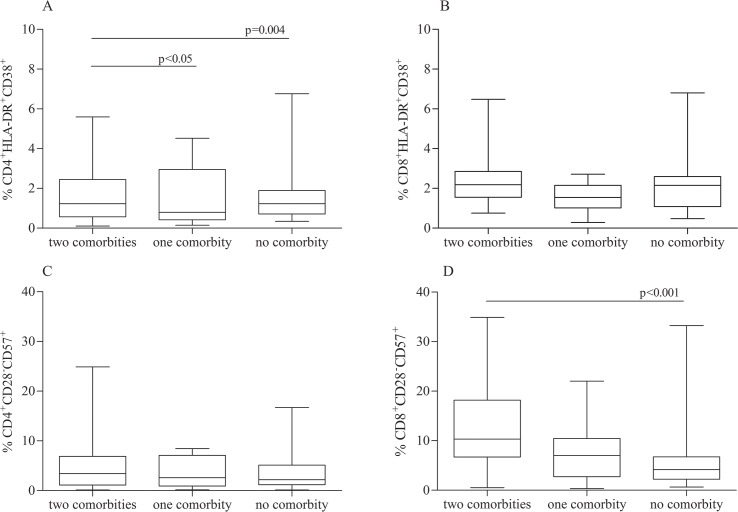
T cells phenotype in HIV infected subjects.CD4+ and CD8+ immune activation (A, B) and immunesenescence (C, D) in HIV-infected subjects according to the presence of bone and vascular diseases: presence of two comorbidties (bone and endovascular damage), only one comorbidity (bone or endovascular damage), no comorbidity. Values are expressed as a percentage. The horizontal bars represent the median. The upper and lower whisker indicate the third quartile +1.5 [Inter Quartile Range (IQR)] and first quartile -1.5(IQR).